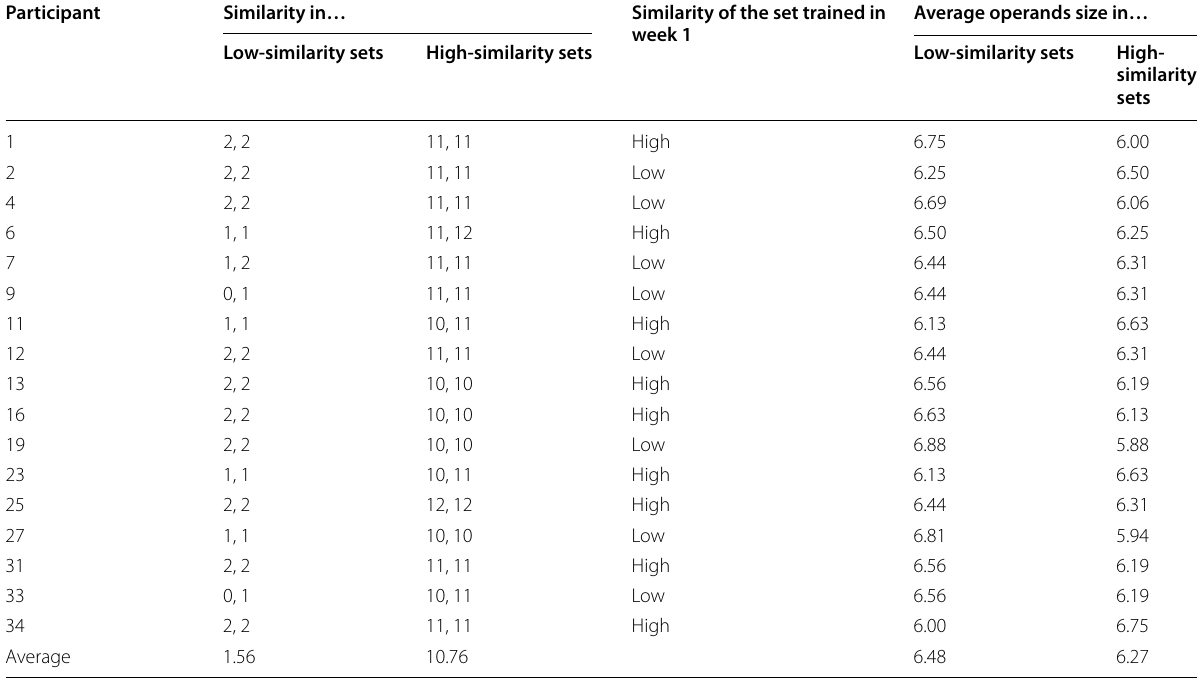
Each set was learned in a separate week (4 weeks overall), in counterbalanced order (either low–high‑low–high or high‑low–high‑low). We made sure that the low‑ similarity sets were not easier than the high‑similarity sets in terms of problem size